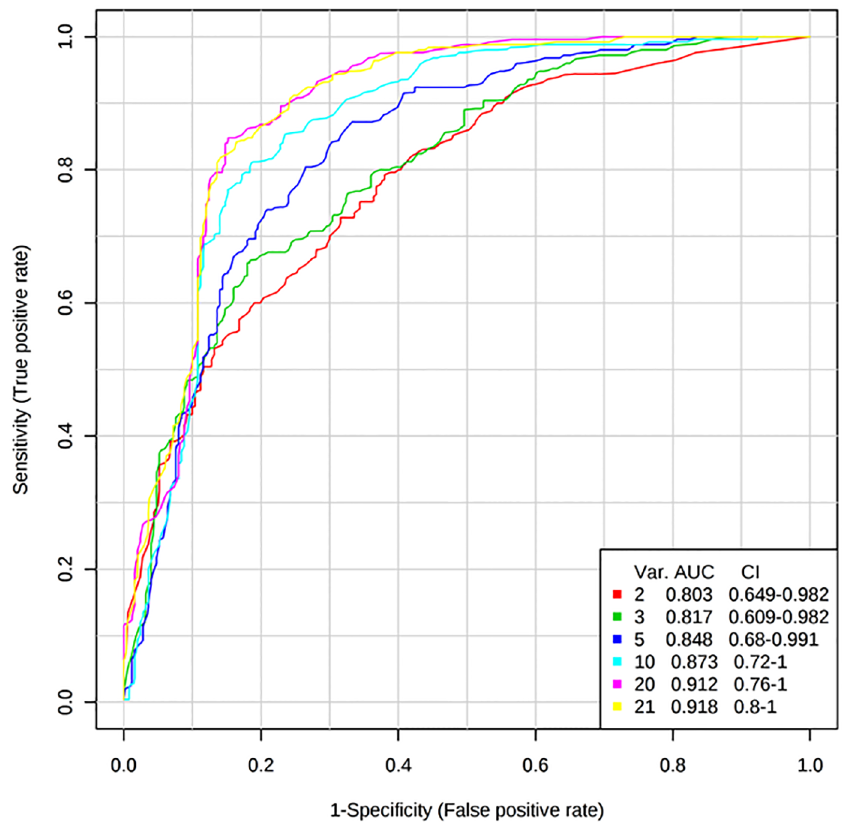
Fig 1. ROC curves for assessment of protein panel to discriminate between low and high disposition index measures. ROC curves to determine the predictive ability of the protein panel (17 proteins associated with the disposition index (p (cid:20) 0.01)), age, BMI, waist to hip ratio and fasting glucose, for classification of low and high disposition index values of MECHE participants (n = 30). Par scaling was used as a scaling method and random forest method was employed for classification of variables. Using all 21 variables, the best ROC curve was produced with an AUC of 0.918. AUC: area under the curve. Var: variable. CI: Confidence interval. Tertile 1: low beta-cell function Tertile 3: high beta-cell